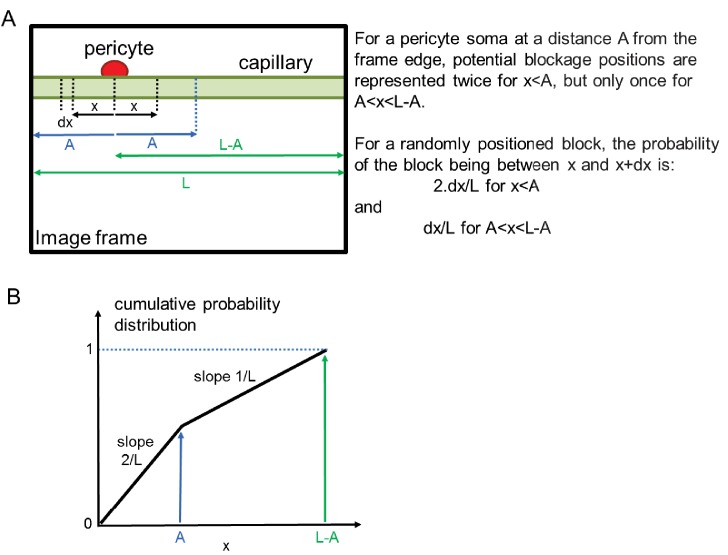
Calculation of probability distribution for distance from a randomly placed block to a chosen pericyte soma.(A) Diagram showing the calculation of the probabilities on the right of the panel. (B) Cumulative probability distribution for the position of a randomly placed block on this capillary. Figure 3H was calculated by averaging over 42 such distributions for capillaries where block was observed.